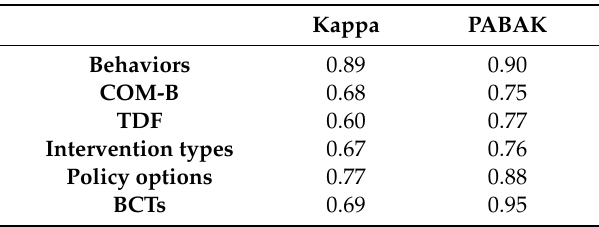
Table 3. Interrater